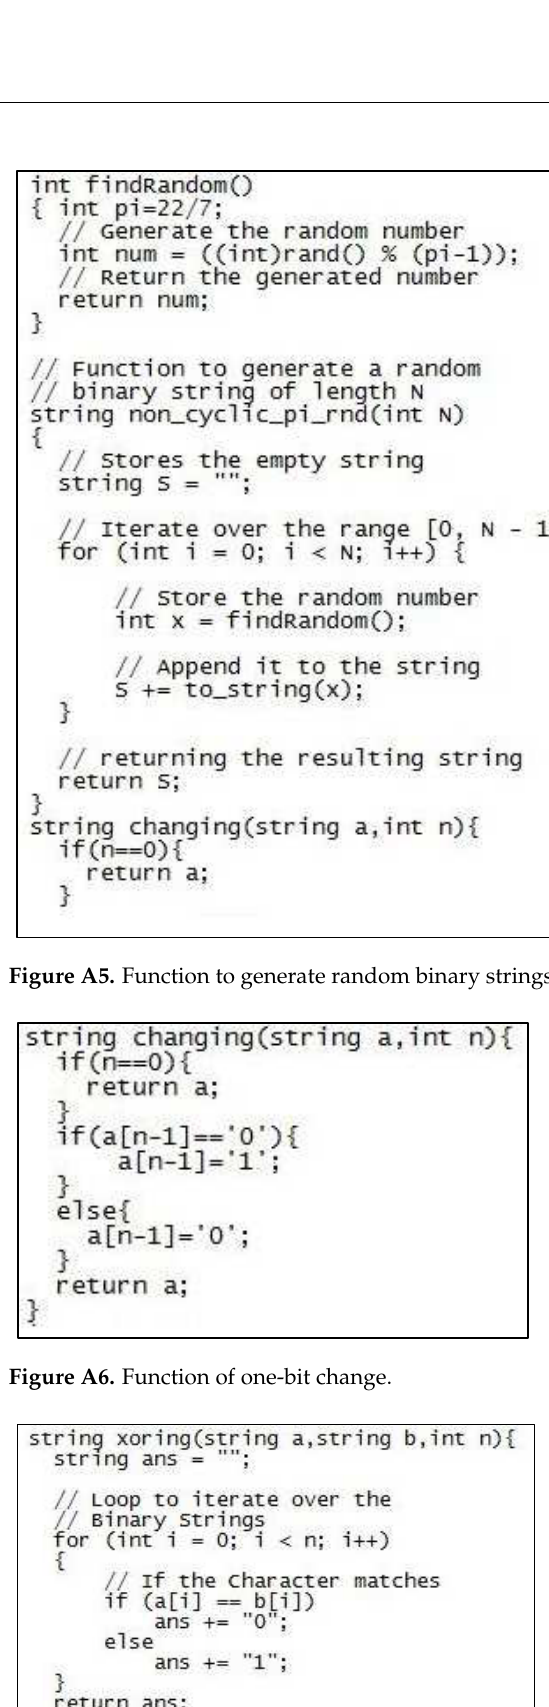
Figure A7. Function of binary XORing .